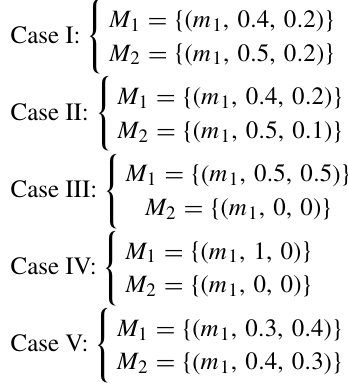
Bold values indicate unreasonable results. x (cid:3) 0 . 2 and y (cid:3) 0 . 8 in D PYY 7 , D PYY 8 , S PYY 7 , and S PYY 8